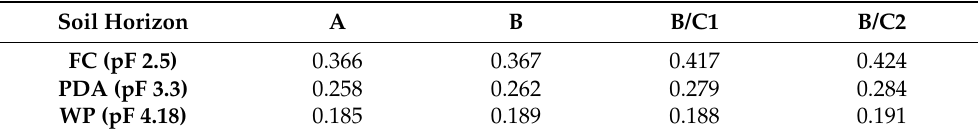
Table 4. Mean values of the critical soil water content (cm 3 · cm − 3 ) of the FC, PDA and WP hydrolimits (calculated) for each horizon of the soil